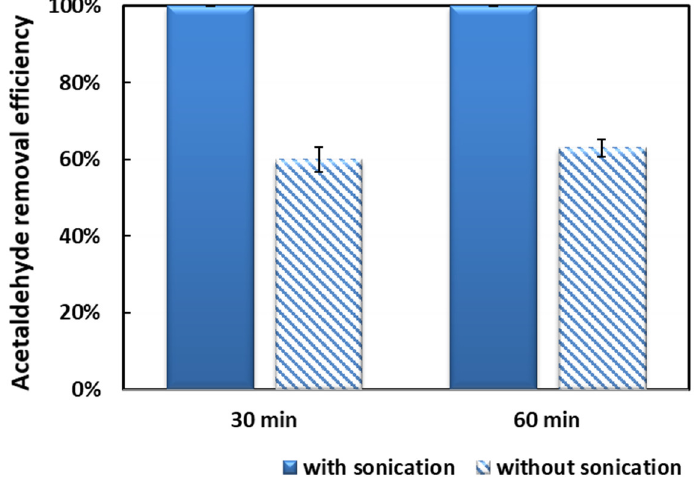
Figure 5. The effect of sonication on the catalytic activity of the 10 wt.% Mn/NZ for the acetaldehyde oxidation. Relative Humidity: 60%, The amount of catalysts: 5 g.